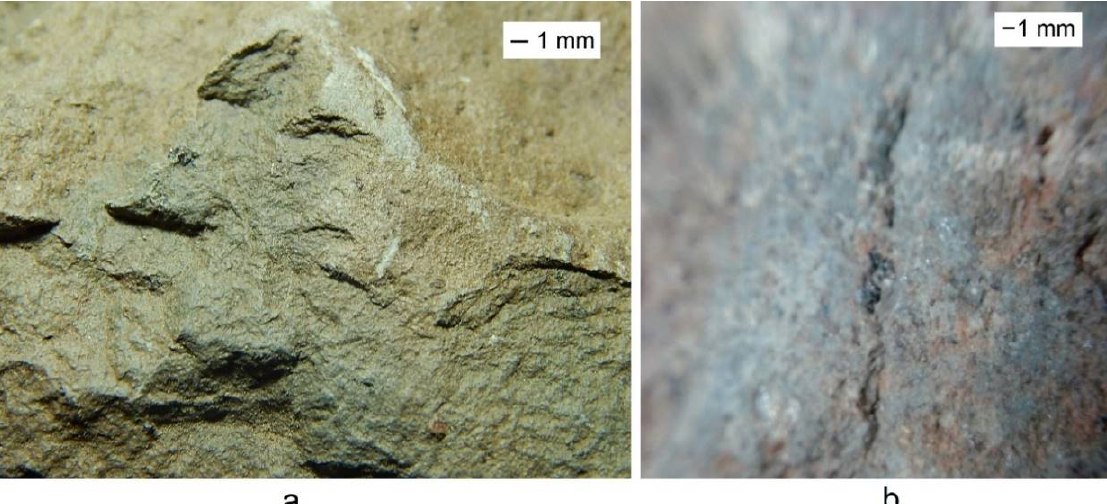
Figure 11. (a) Specimen 1, multiple sequential step-fracture scars on the tool body. (b) Specimen 5, a striation parallel to the longitudinal axis of the tool. (Photographs by Steve